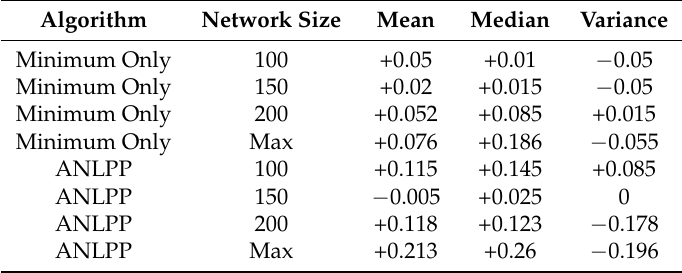
Figure 7. All algorithms’ performance over 10,000 networks of fixed size. Upper left is for size 100 nodes, upper right 150 nodes, lower left 200 nodes, and lower right maximum size to charge a single node (between 233 and 237). Table 3. Tuning impact on algorithms’ performance